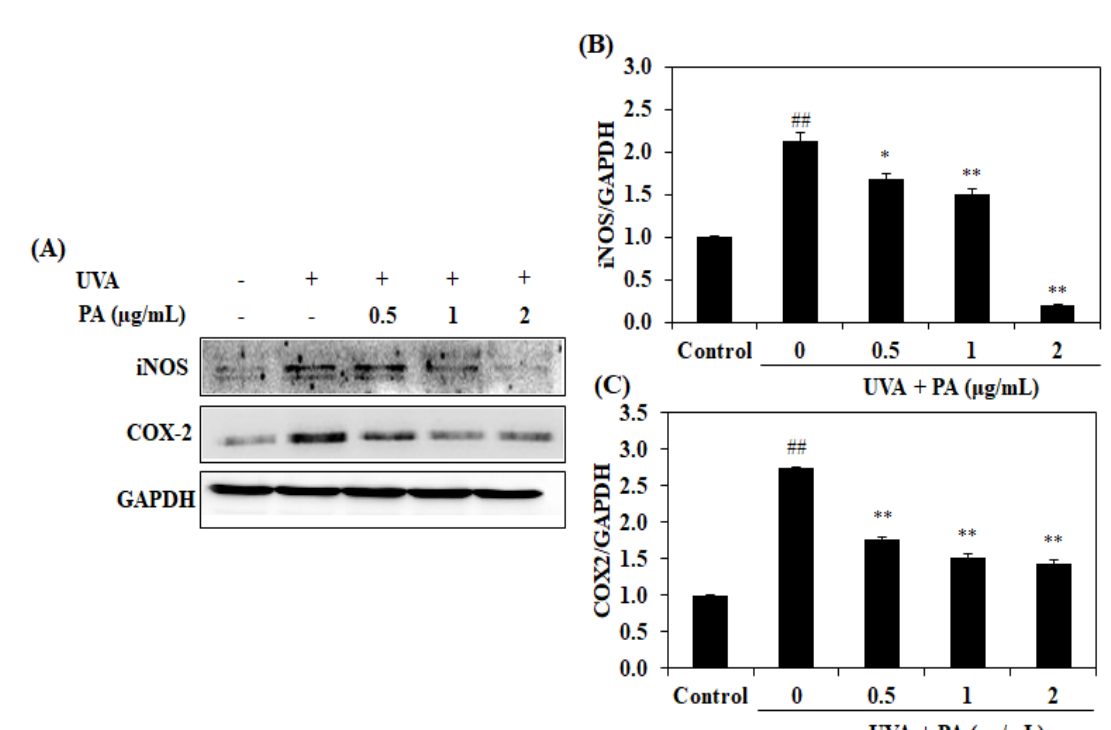
Figure 3. Effects of PA on COX-2 and iNOS expression in UVA-irradiated HDF cells. The iNOS and COX-2 protein expression ( A ) and the relative ( B ) iNOS and ( C ) COX-2 protein expression levels. The levels were compared with GAPDH. The values are expressed as the mean ± SD in triplicate experiments. ## p < 0.01 indicates a significant difference compared to the control groups. *p < 0.05 and **p < 0.01 indicate a significant difference compared to the only UVA-irradiated groups.